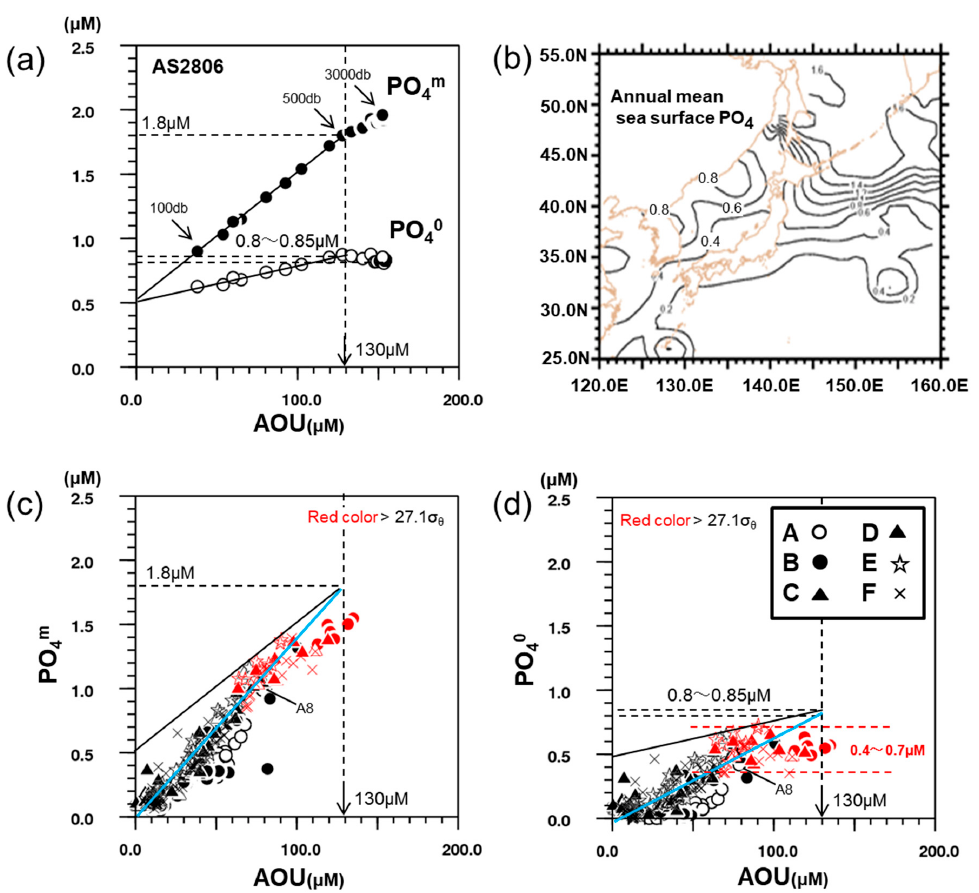
Figure 10. ( a ) The PO 4m -AOU and PO 40 -AOU plots for all samples from subsurface (100 db) to bottom (3000 db) at AS2806 in December of 2011; ( b ) the annual mean distribution map of sea surface PO 4 in the Japan Sea; ( c , d ) the PO 4m -AOU and PO 40 -AOU plots for the upper layer ( < 300 db), including all samples in lines A to F.